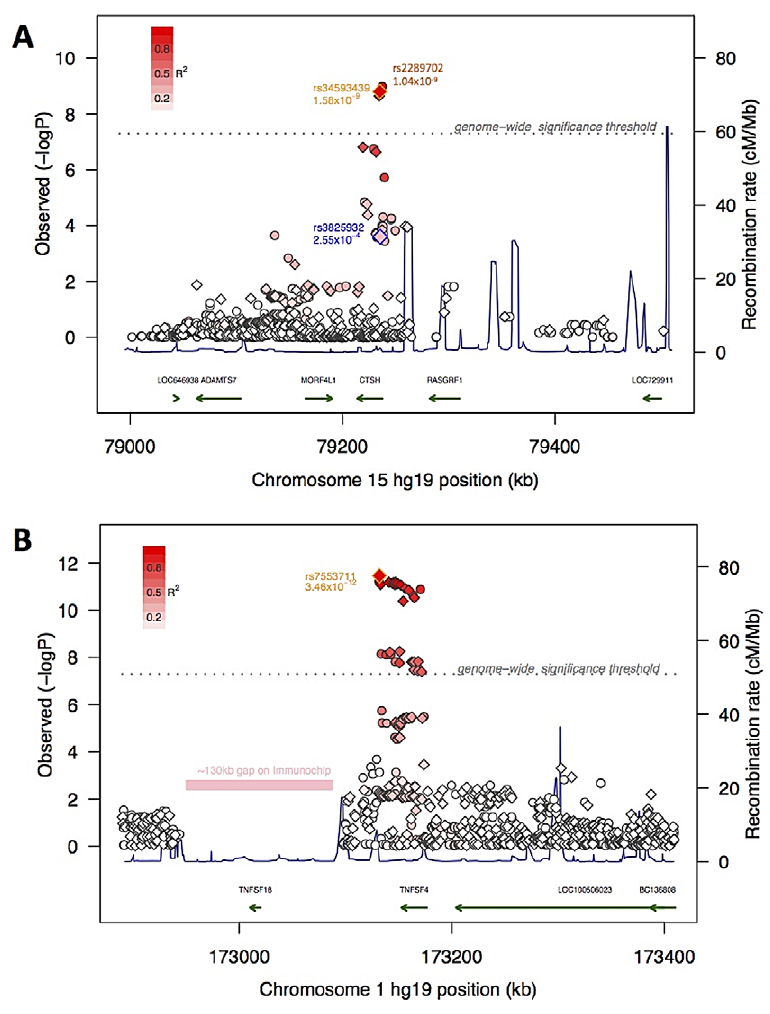
Figure 2. Association signal at the mapping intervals flanking rs34593439 and rs7553711. Association scores at 15q25.1 (panel A) and 1q25.1 (panel B). Genotyped (diamonds) and imputed (circles) SNPs are indicated and the top genotyped SNP in the interval is outlined in orange. A SNP in 15q25.1 previously associated with Diabetes is outlined in blue. The degree of red color in each diamond or circle indicates the strength of LD with the top SNP (on a scale shown in the legend at the upper left hand corner of the plot). The X-axis shows the chromosome and physical distance (kb) from the human genome reference sequence (hg19), the left Y-axis shows the negative base ten logarithm of the p-value and the right Y-axis shows recombination rate (cM/Mb) as a navy line. The genome-wide significance threshold (P , 5 6 10 2 8 ) is given by the dashed grey line. Genes in the regions are annotated at the bottom as green arrows. Also indicated in 1q25.1 is a , 130 kb region with no SNPs on the ImmunoChip.